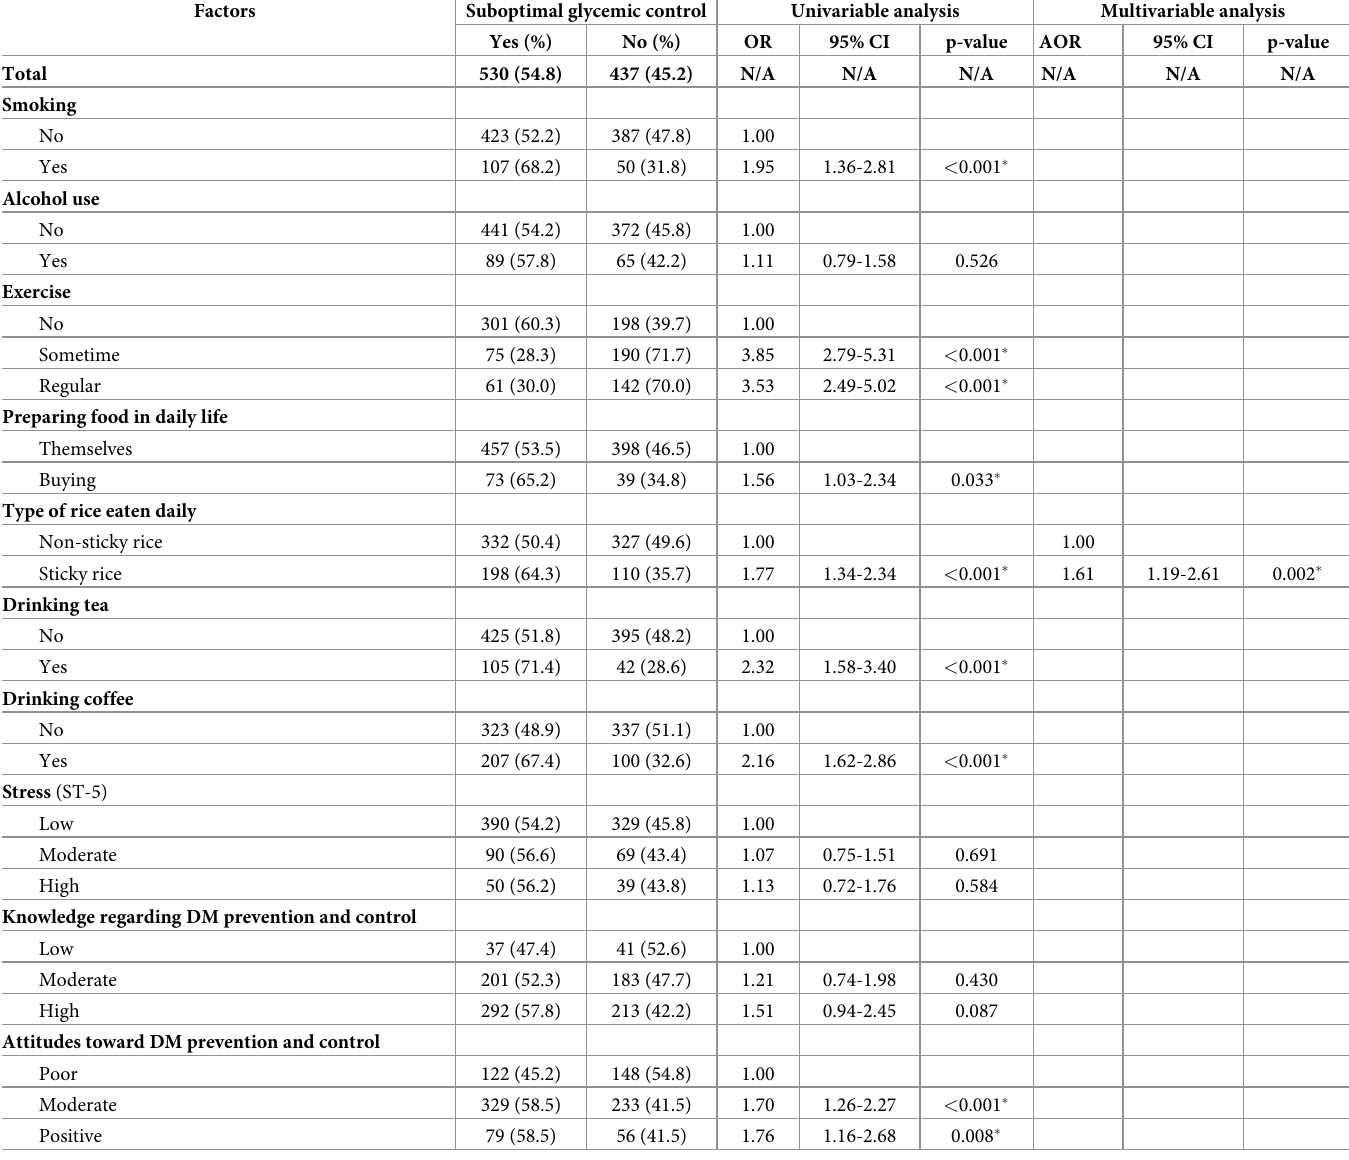
Table 5. Identifying behavioral and psychological determinants associated with suboptimal glycemic control among DM patients by univariable and multivariable logistic regressions.